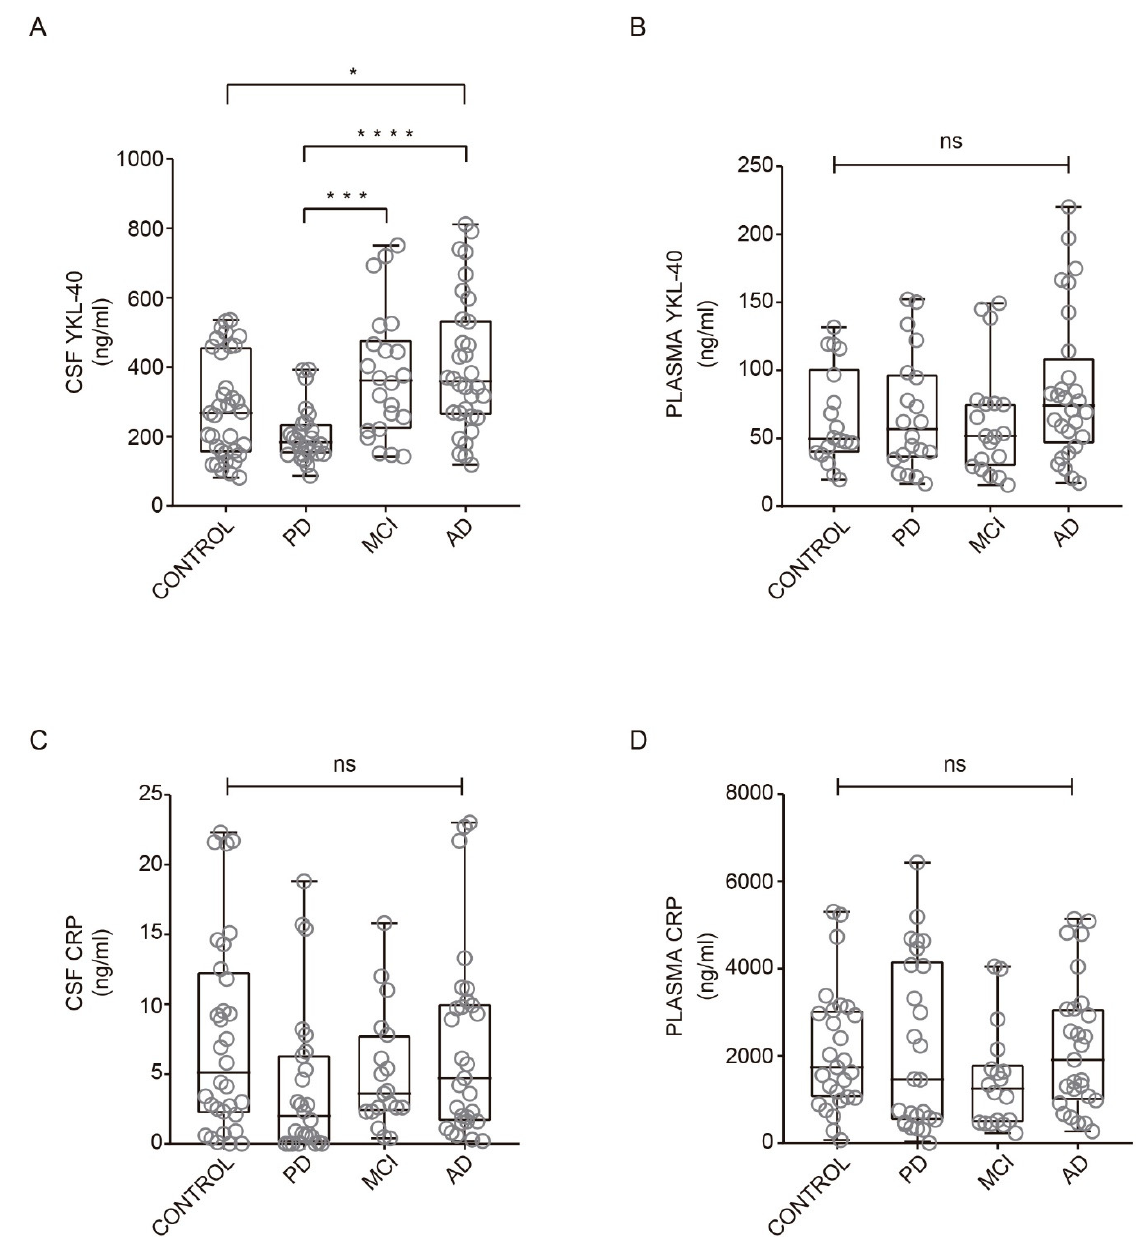
Figure 1. YKL-40 and CRP levels in CSF and plasma in different diagnostic groups. Box-and-whisker plots showing ( A , B ) YKL-40 and CRP levels ( C , D ) in CSF and plasma, respectively, across the diagnostic groups. Differences between groups were assessed using Kruskal–Wallis test followed by Bonferroni correction. * p < 0.05; *** p < 0.001; **** p < 0.0001. MCI, mild cognitive impairment; AD, Alzheimer’s disease dementia; PD, Parkinson’s disease. ns: non-significant.